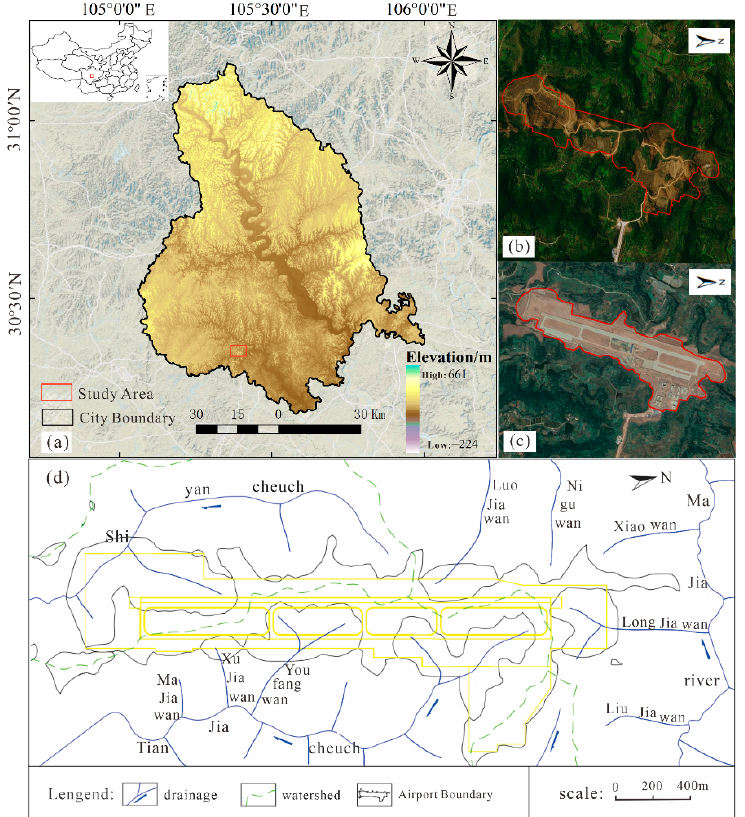
Figure 1. ( a ) Study area scope map; ( b ) study area scope map in 2013; ( c ) study area scope map in 2021; ( d ) study area drainage map (the coordinate system is WGS84, and the software used to draw the pictures are ArcGIS and Surfer).